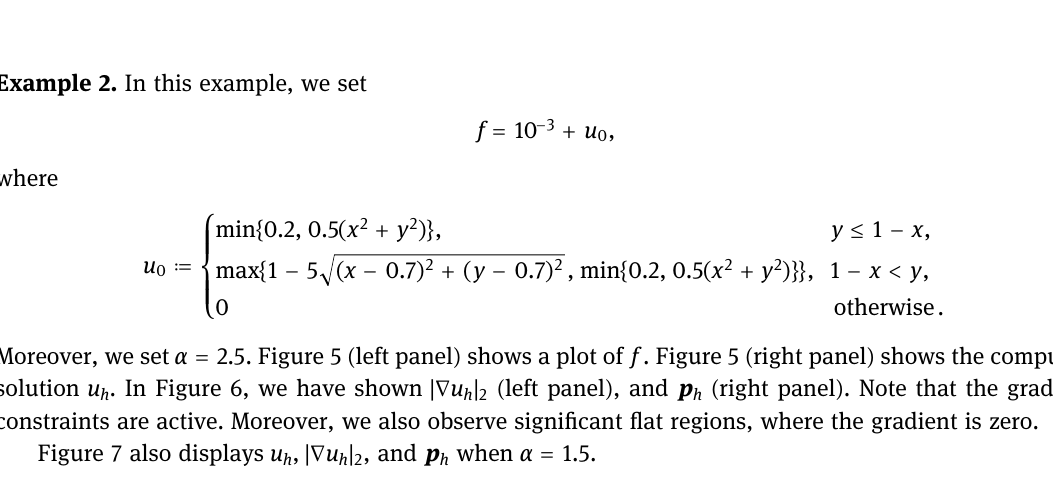
. The columns represent f 1 = , 0.25, and 0.1. h